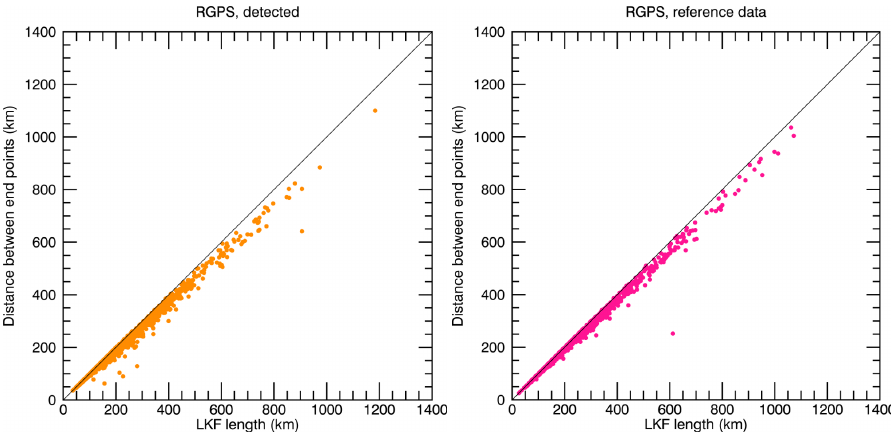
Figure 12. Endpoint distance vs. integrated line length as an indicator of feature linearity. ( a ) Detected objects; ( b ) Reference data ( R 10 ).